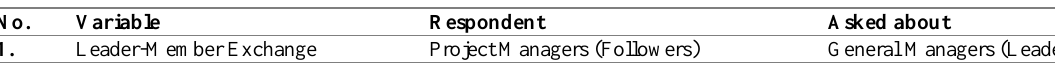
Table 2: Data Collection Scheme